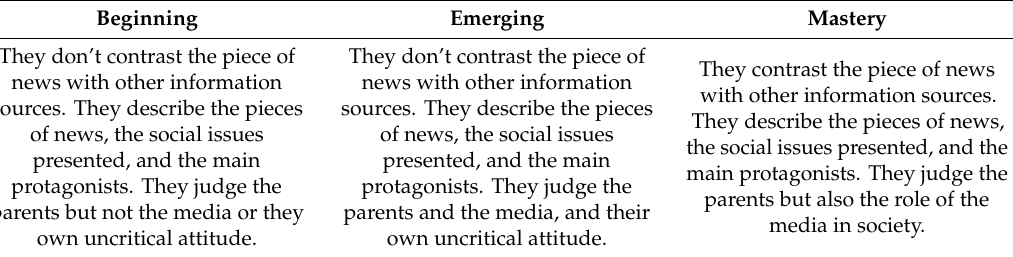
Table 2. Rubric utilized to analyze results of activity 2.